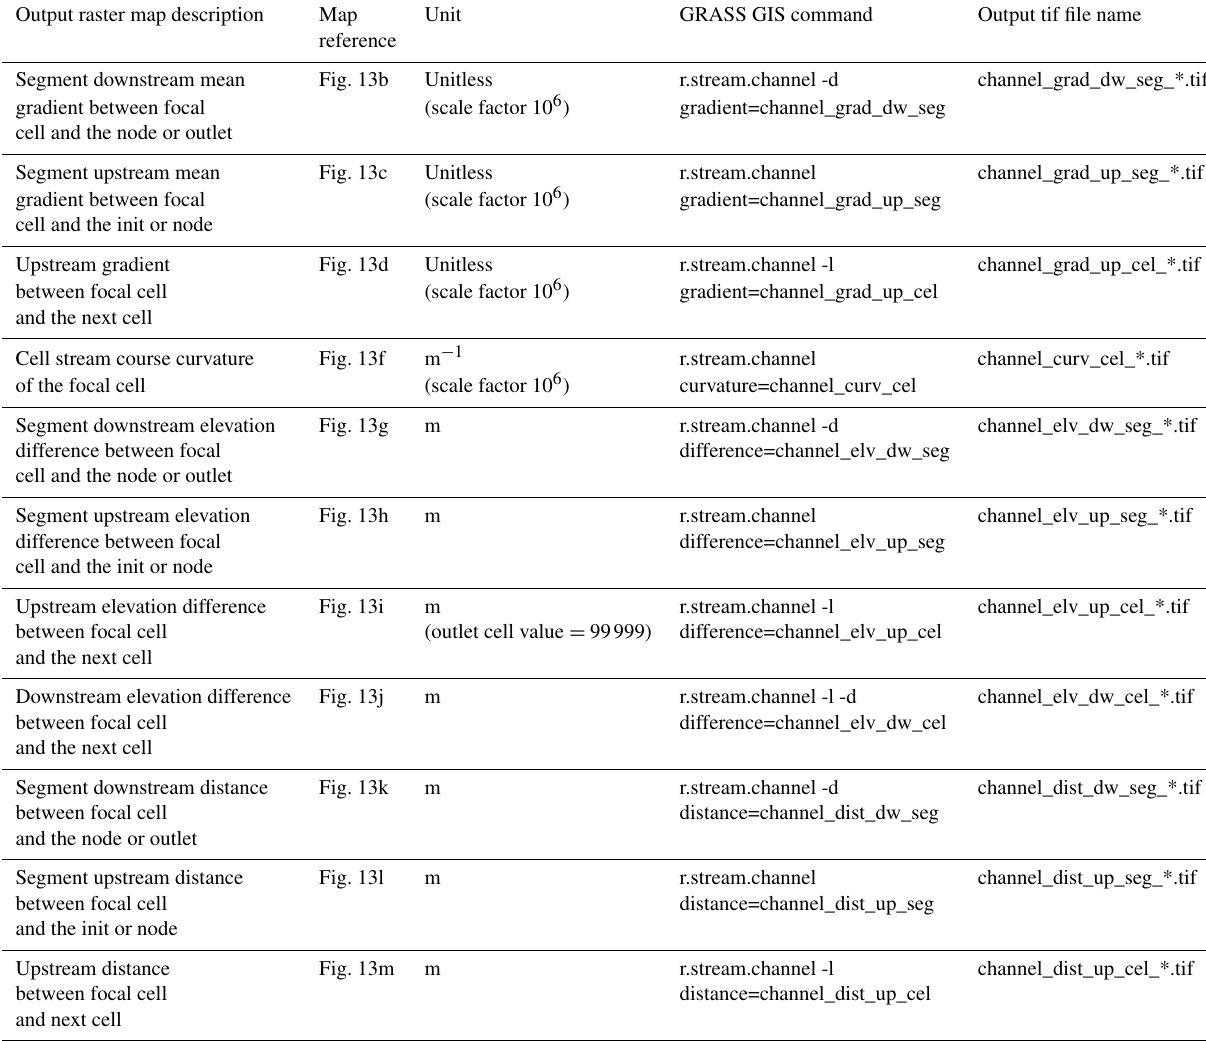
Table 5. Curvature, gradient (elevation difference divided by distance), and elevation change raster maps computed with the r.stream.channel GRASS GIS module; map reference corresponding to Fig. 13; unit; GRASS GIS command; and output layer name.